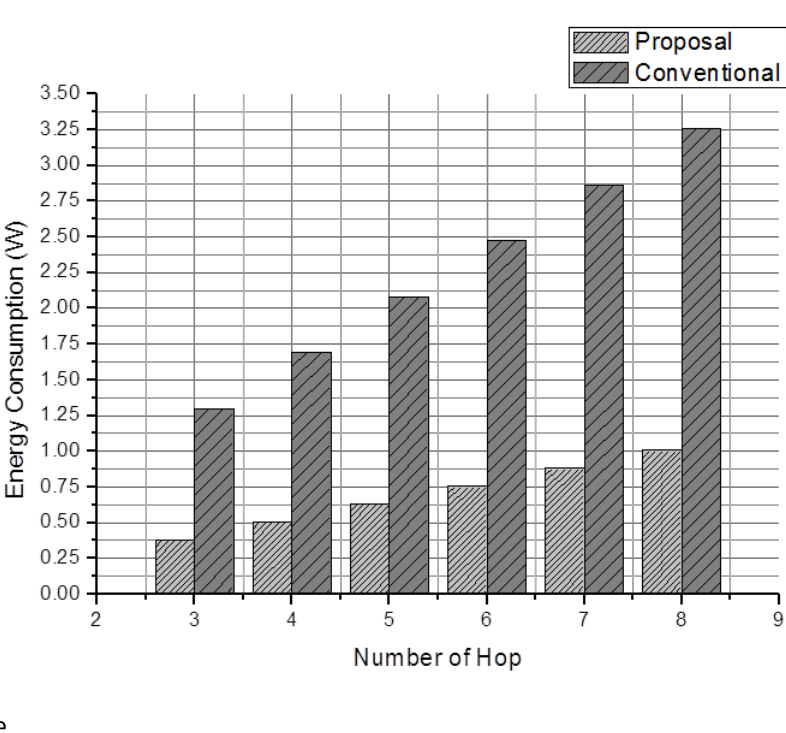
Figure 9. Estimated energy